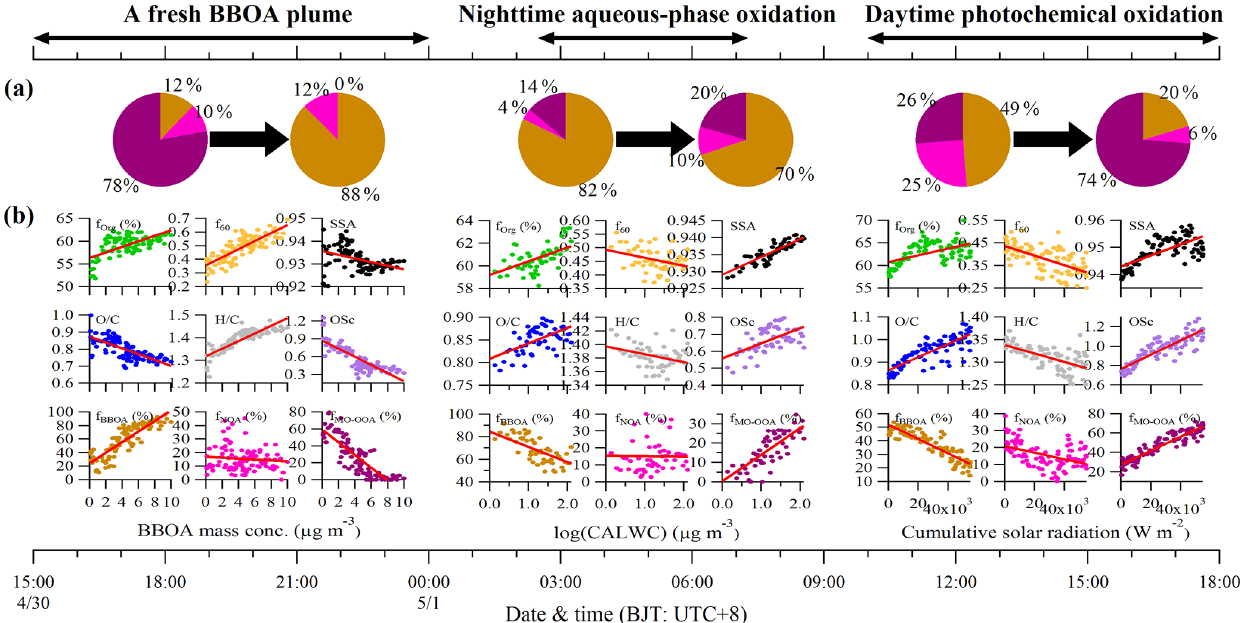
Figure 13. Case study of chemical evolution of BB plume from 30 April at 15:00LT to 1 May at 18:00LT. The periods marked with arrows are three distinct evolution processes. Pie charts in (a) are the mass contributions of three OA factors to total OA at the beginning and end of each process, respectively. The scatter plots in (b) are the aerosol chemistry parameters as a function of BBOA mass concentration, logarithmic values of cumulative aerosol liquid water content (CALWC), and cumulative solar radiation for the corresponding